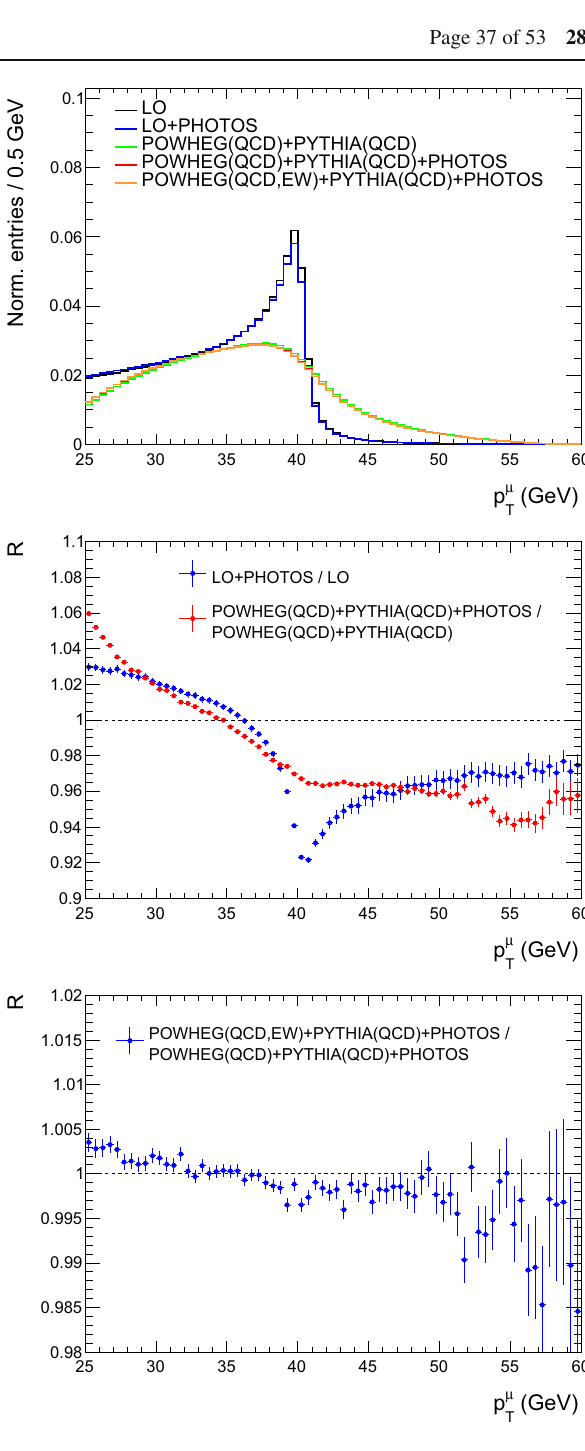
Fig. 34 Combination of QCD and EW corrections in the process pp → μ + ν μ + X at the 14 TeV LHC with standard ATLAS/CMS cuts for the lepton-pair transverse mass ( left plots ) and the charged lep- ton transverse momentum ( right plots ) distributions. The normalized distributions in different perturbative approximations are shown in the upperplots .TheratioofthesedistributionsincludingaQEDFSRPSand